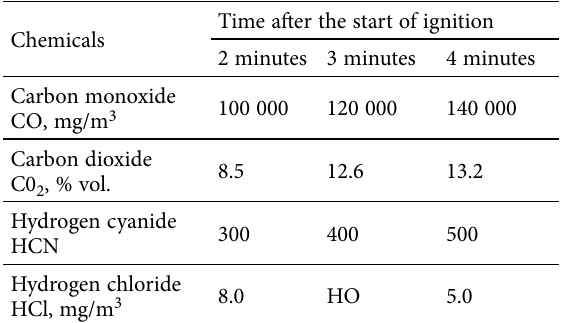
Table 2. Determination of chemical compounds in the air in the passenger